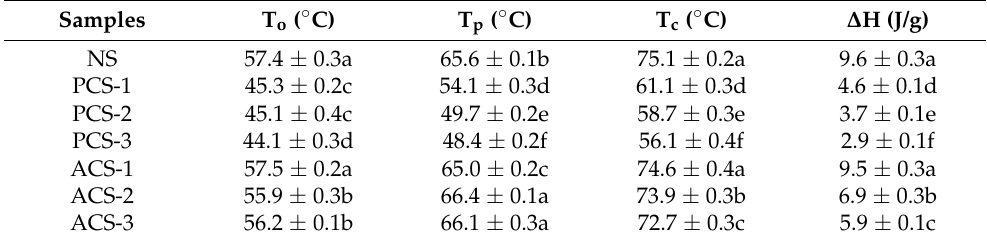
Table 3. Thermal properties of native, phosphorylated and acetylated chestnut starch. Samples